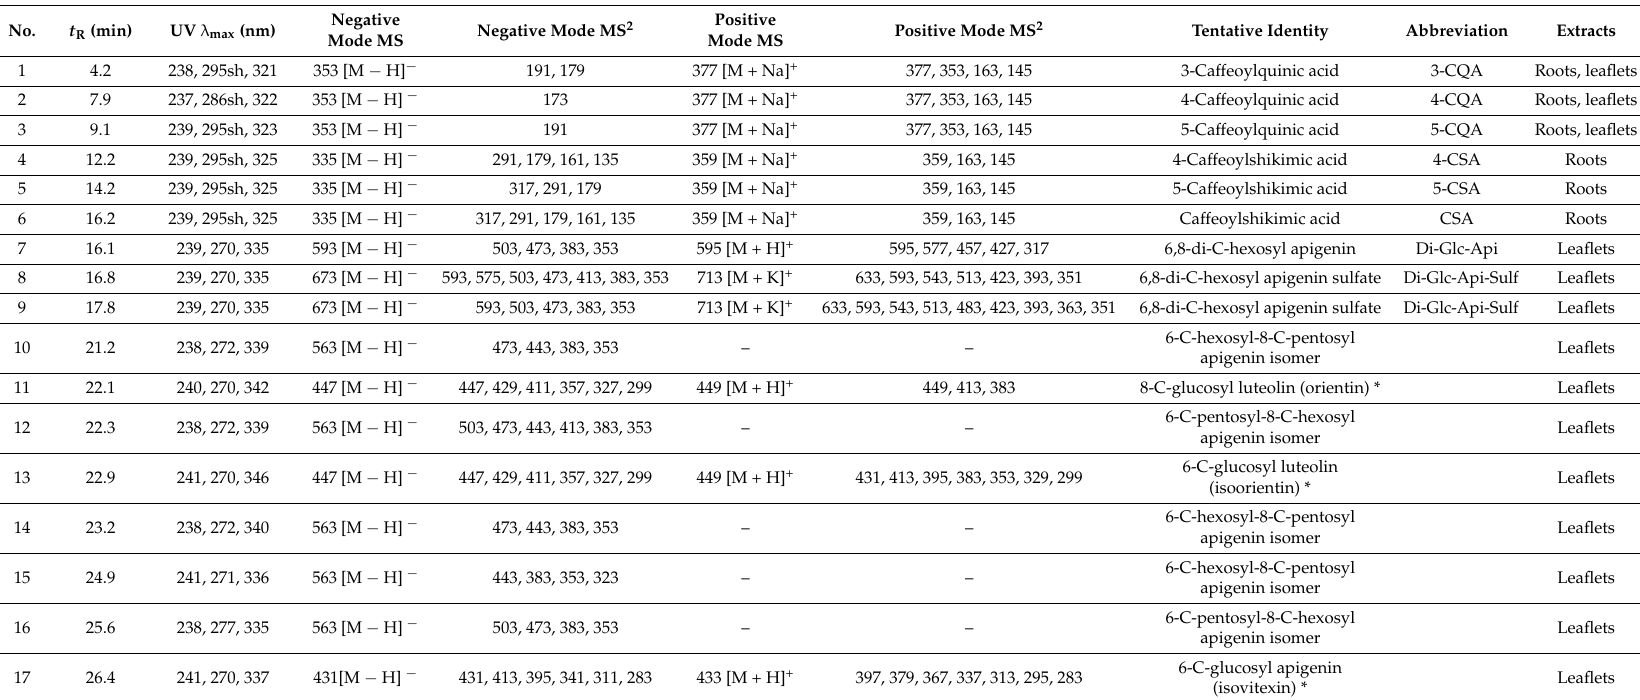
Table 4. Identification of main components of root and leaflet extracts of Oenocarpus bacaba and Oenocarpus